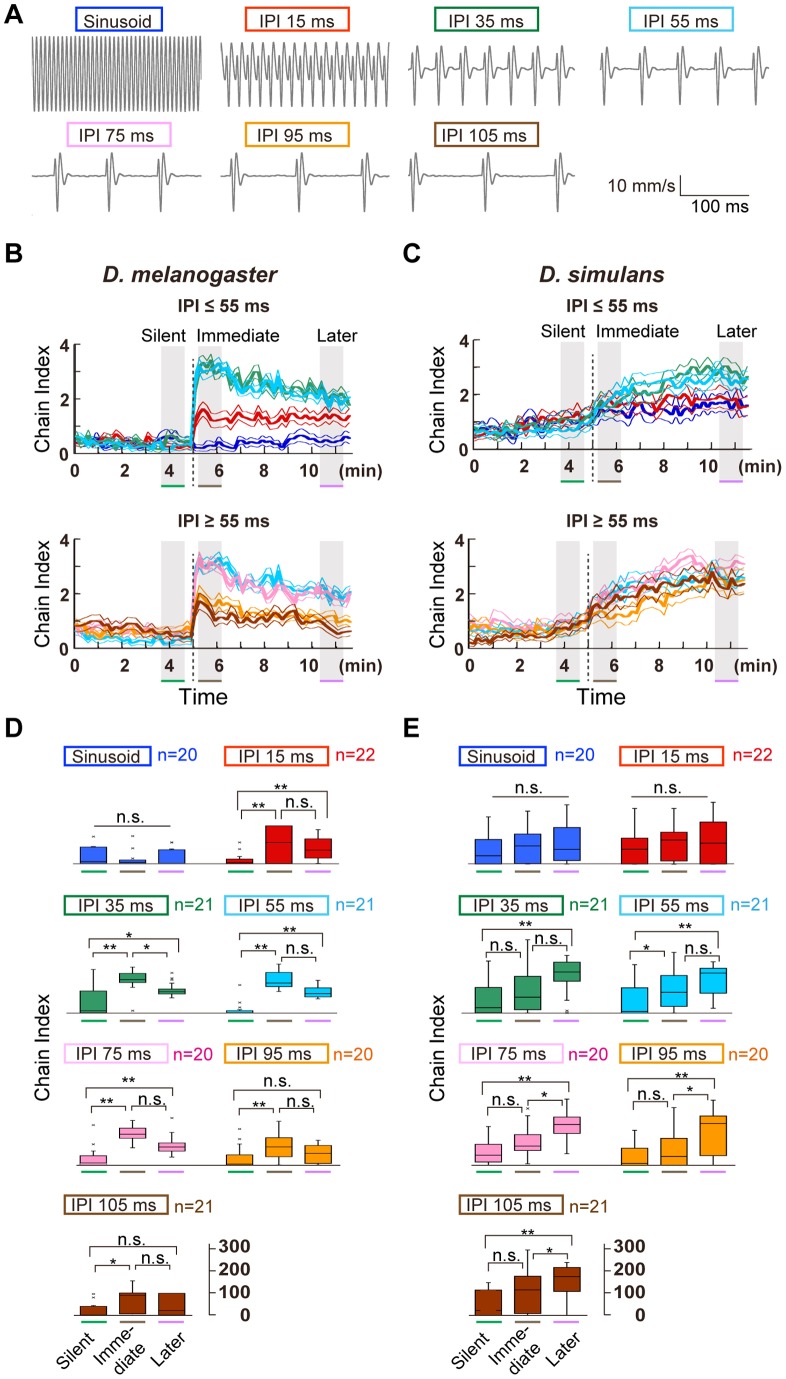
Selectivity to different IPI songs in two Drosophila species.(A) Artificial song patterns used in this assay. (B and C) Chain index of D. melanogaster (B) and D. simulans (C) flies to artificial songs that carry various IPIs. Time-courses to the IPIs shorter (top) and longer (bottom) than 55 ms are shown. Time windows for three temporal phases are hatched in gray. (D and E) D. melanogaster (D) and D. simulans (E) responses in three temporal phases to artificial pulse songs of varying IPIs. Original time traces are shown in Figure 3B and 3C. Responses to artificial sine song, and pulses of 15, 35, 55, 75, 95, and 105-ms IPIs are color coded in blue, red, green, sky blue, pink, orange, and brown, respectively, in panels (B–E).